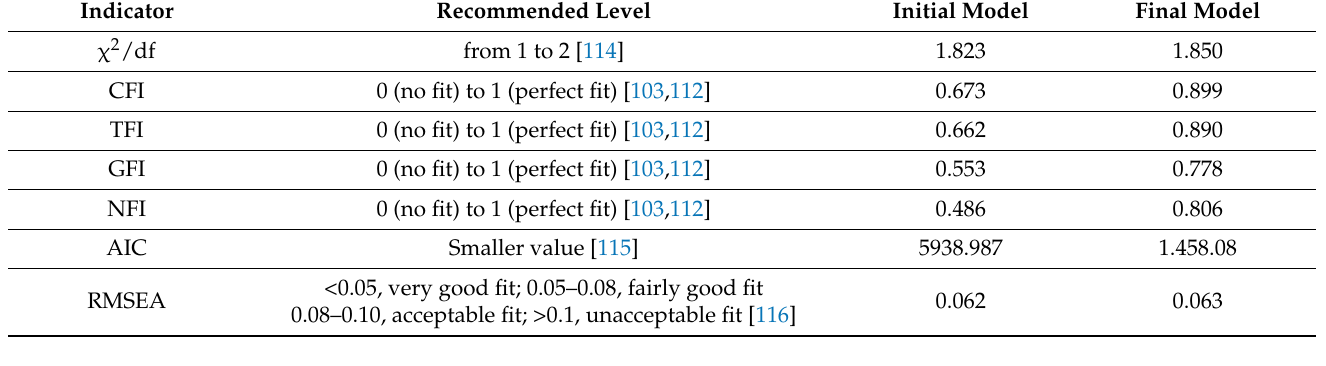
Table 5. Goodness-of-fit.